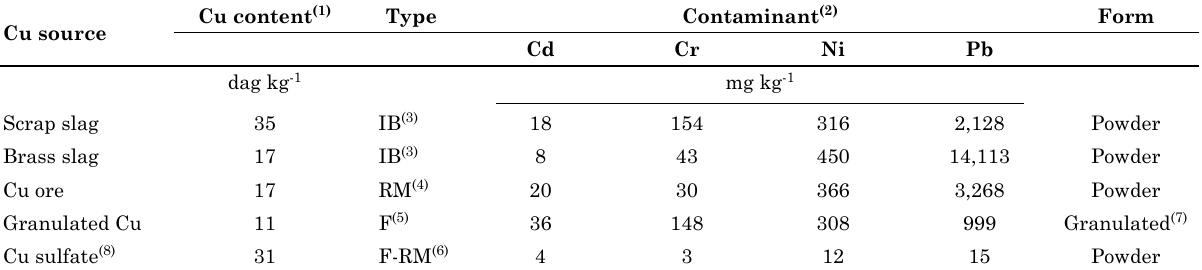
Table 1. Characterization of Cu sources evaluated for mineralogical composition and soluble contents in several extractants Cu source